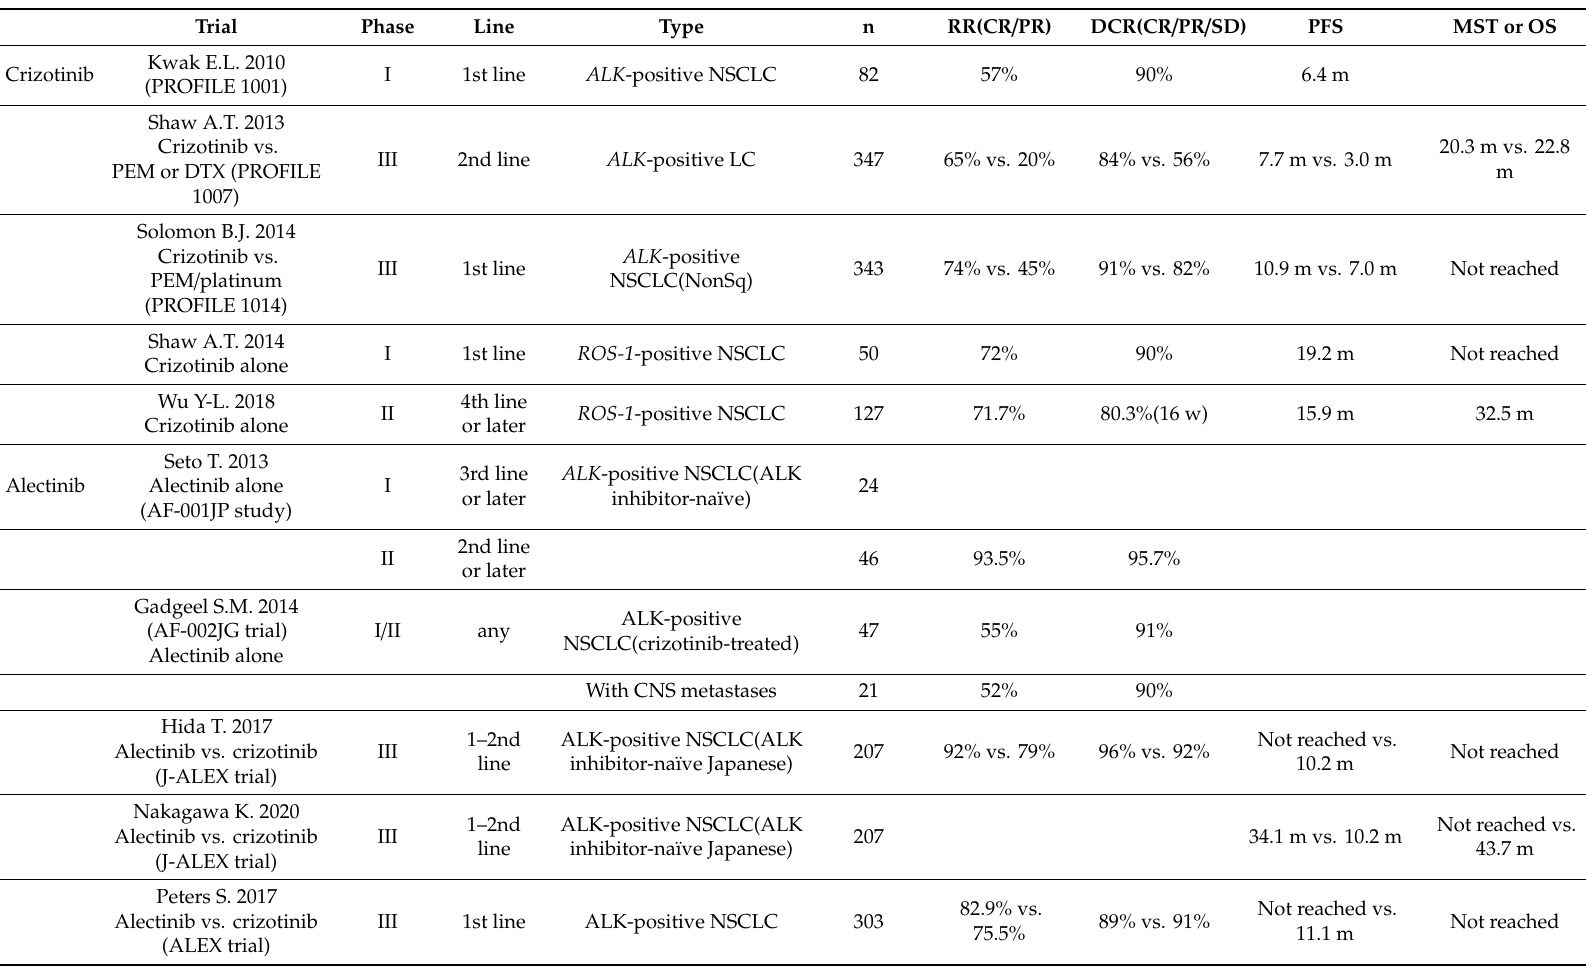
Table 2. Results of clinical trials of crizotinib and